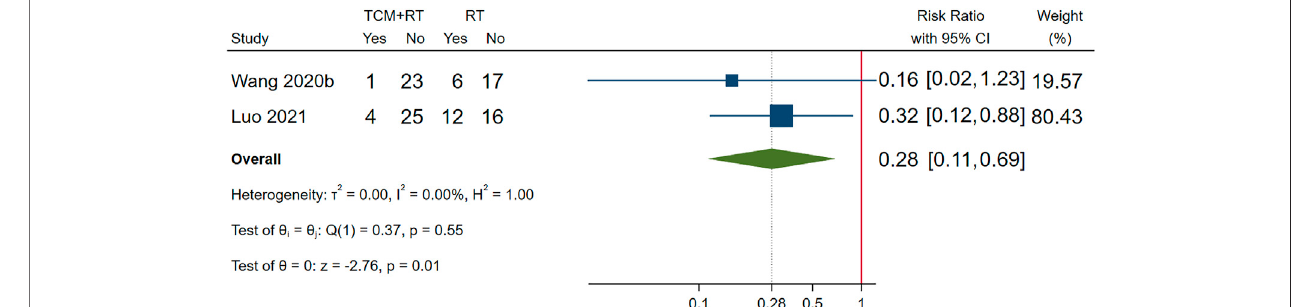
FIGURE 6 | Forest plot of ARDS.